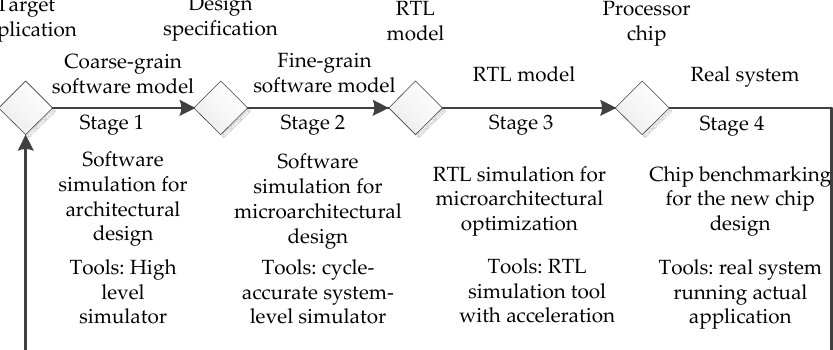
Figure 1. Conventional processor design flow for architecture optimization based on